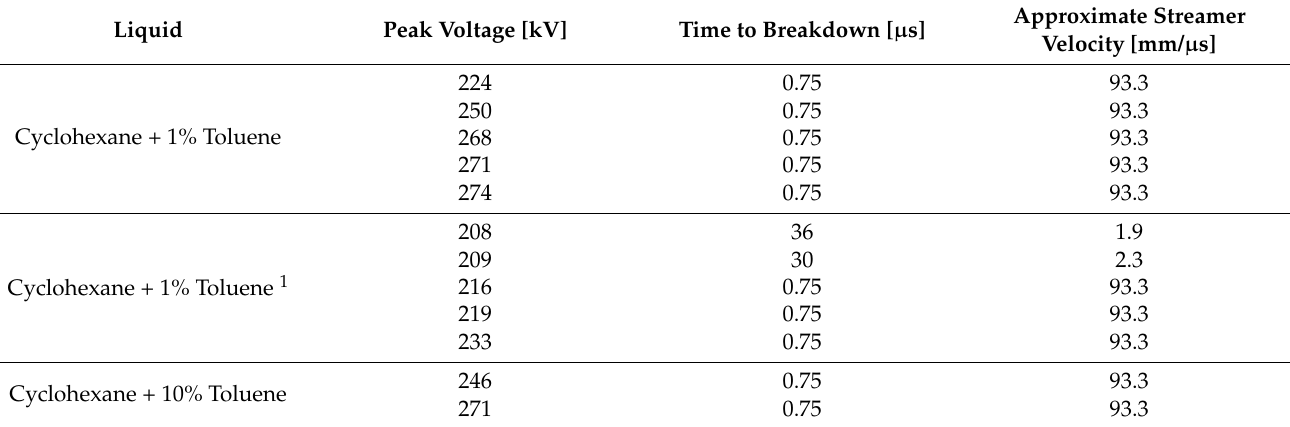
Table 4. The time to breakdown and inferred overall streamer velocity for 1% and 10% (by volume) of toluene in cyclohexane. Applied voltage was a positive polarity lightning impulse (1.2/50 µ s) with a 70 mm gap (point-plane